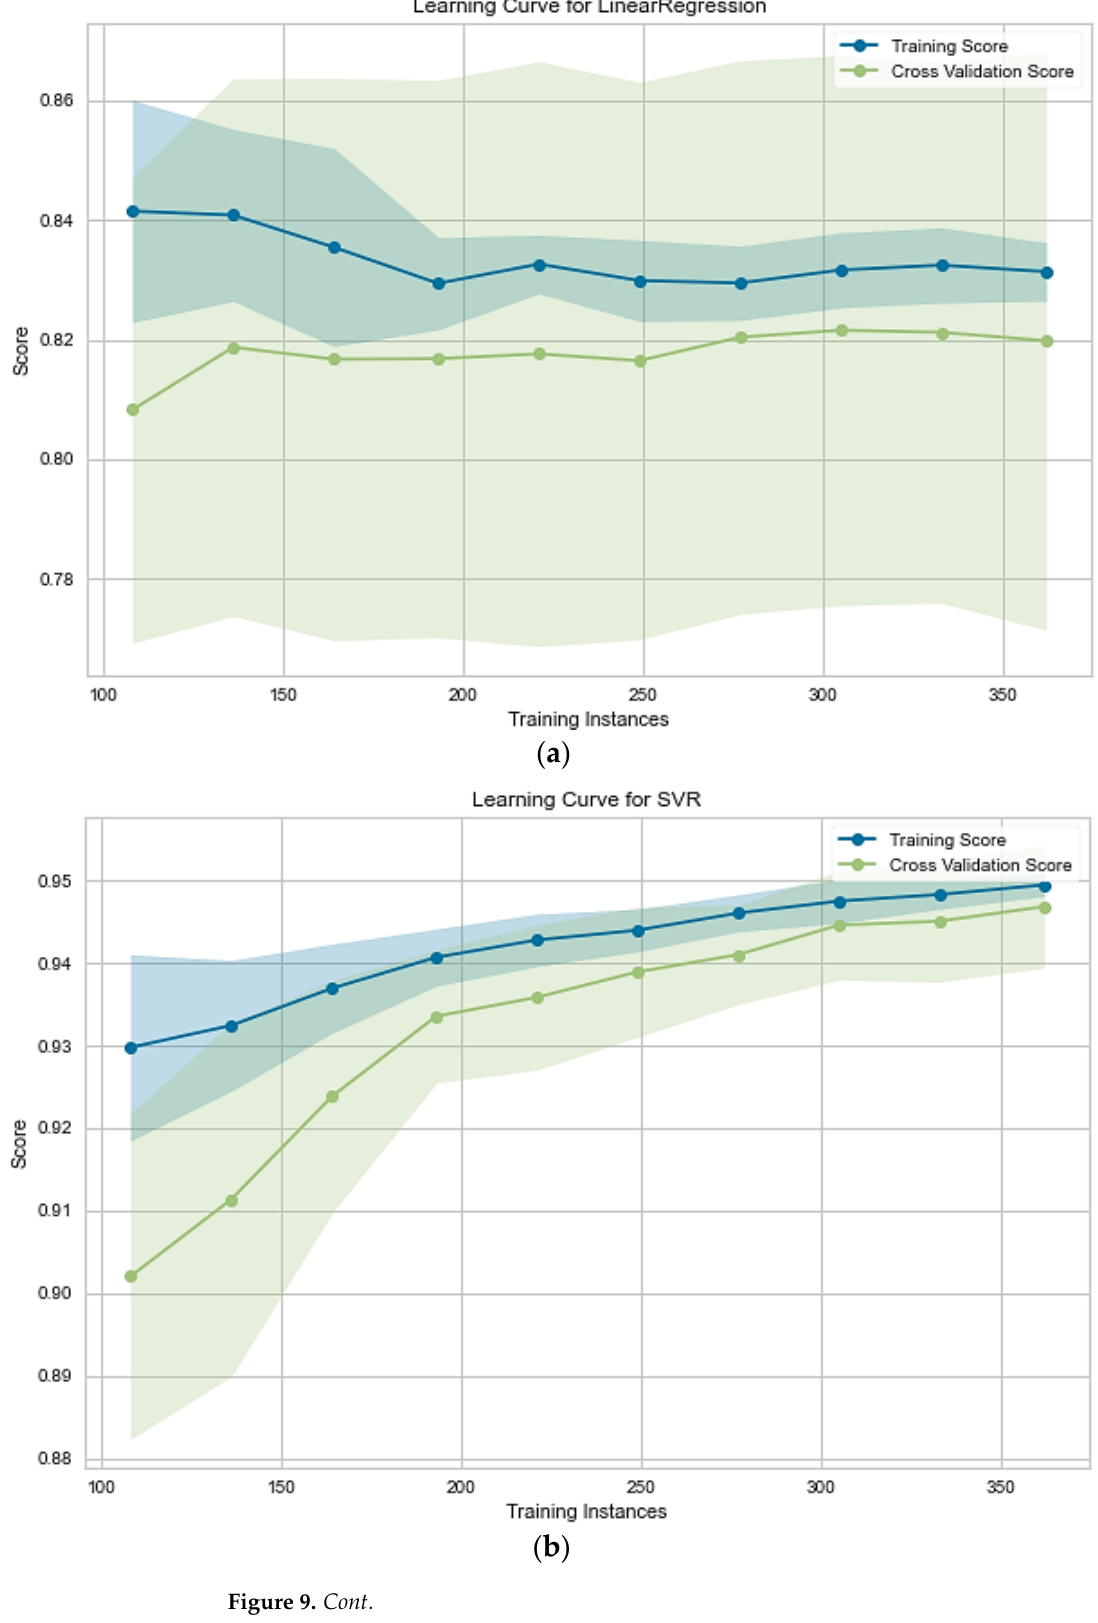
( d ) Figure 8. Different machine learning models’ prediction error on test data for ( a ) linear regressor; ( b ) support vector regressor; ( c ) Gaussian process; and ( d ) multilayer perceptron. It is worthy to note that the number of samples can significantly affect models’ a ccu- racy and generalization. The more samples, the better the accuracy score and generaliza- tion are expected. In some cases, however, a higher number of samples is helpful for a